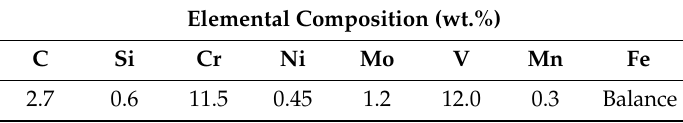
Table 1. Chemical composition of the filler wire FeV12 (ø 1.2 mm).